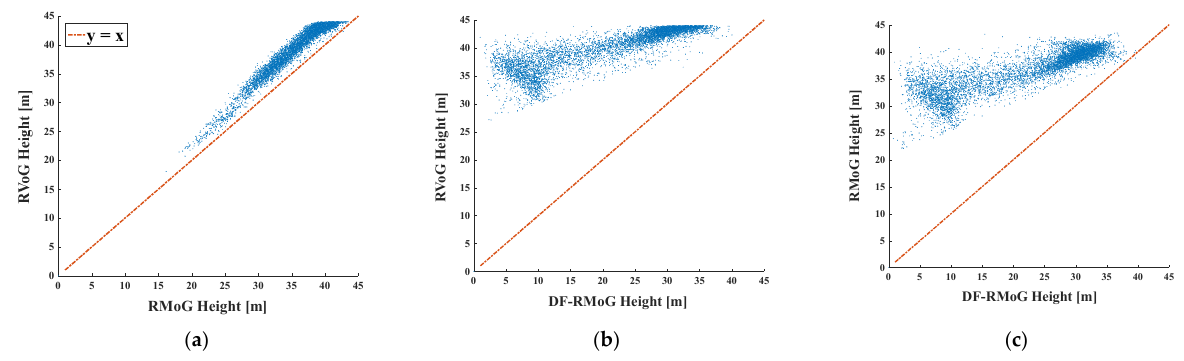
Figure 11. Scatter plots showing the comparison of three models (temporal baseline of 92 days): ( a ) RVoG vs. RMoG. ( b ) RVoG vs. DF-RMoG. ( c ) RMoG vs. DF-RMoG.